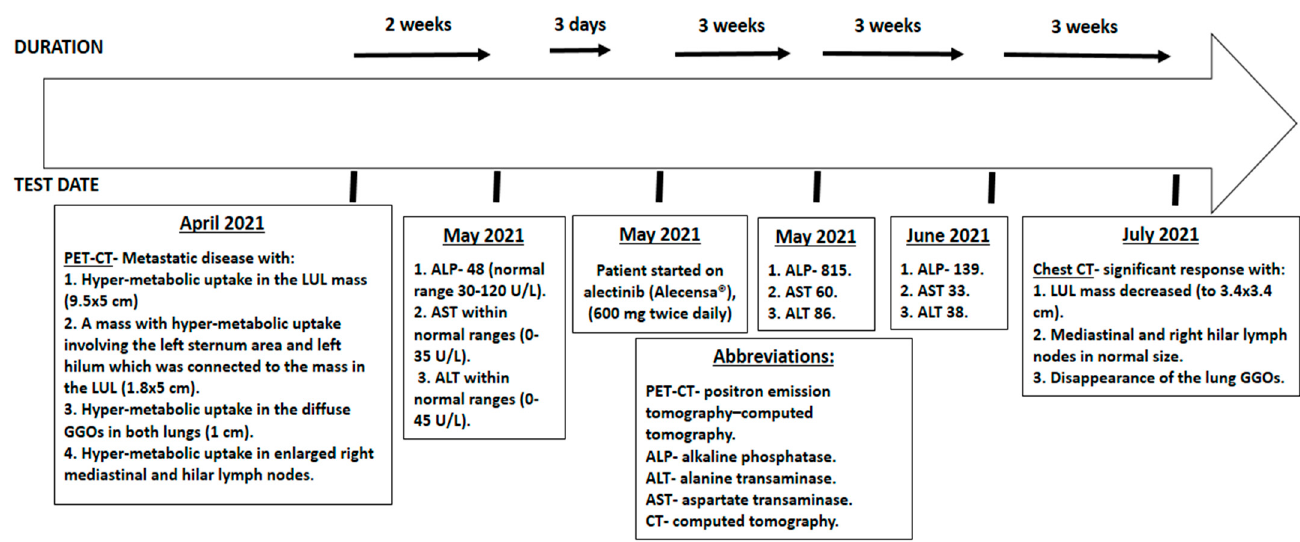
Figure 2. The patient’s time line for cancer treatment and alectinib ‐ induced elevation of